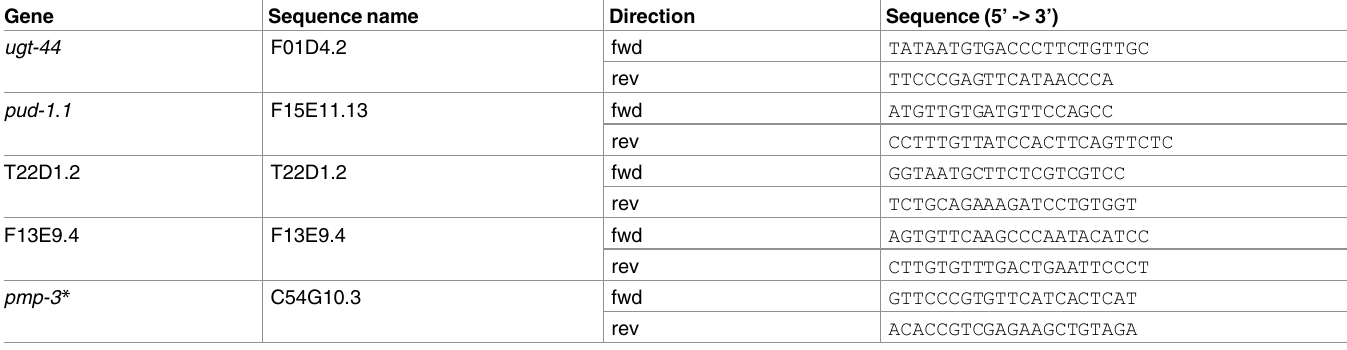
Table 1. Overview of primers used for